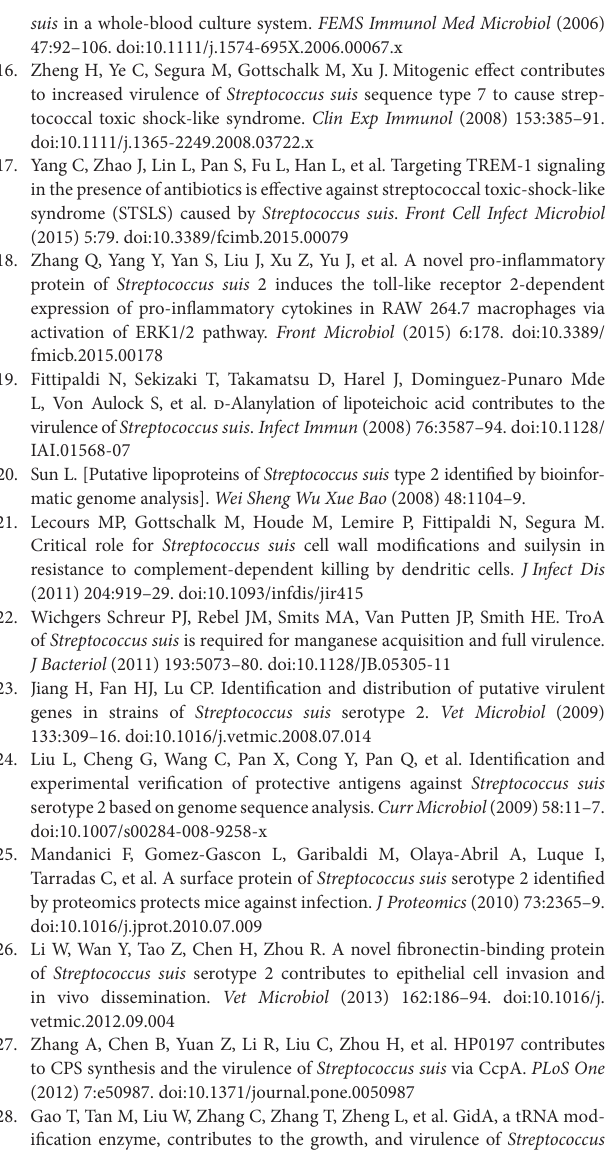
FigUre s1 | Detecting the peptidoglycan (PGN) hydrolase activity of HP1330. As a substrate for zymogram analysis, SS2 PGN was uniformly added to two protein gels. Following SDS-PAGE: (a) one gel was stained with Coomassie blue to observe the positive control lysozyme, the negative control bovine serum albumin (BSA) protein, and HP1330, and (b) another gel was stained with methylene blue to detect the PGN hydrolase activity of lysozyme, BSA, and